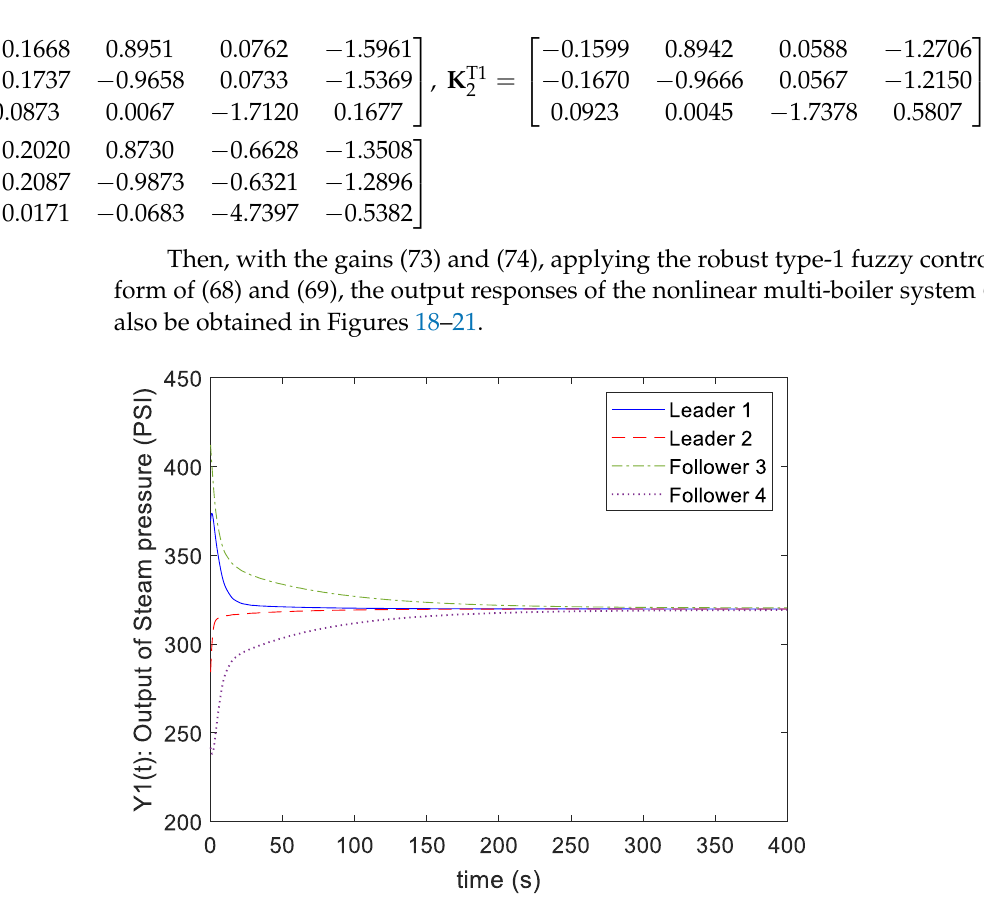
Y t with type-1 robust fuzzy control. Figure 18. Responses of output   Figure 18. Responses of output Y 1 ( t ) with type-1 robust fuzzy 1